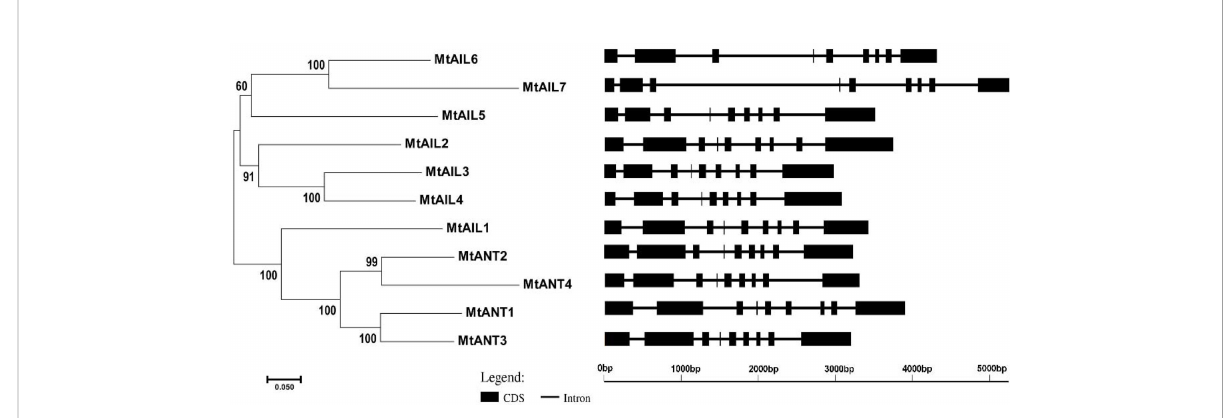
FIGURE 2 The phylogenetic relationship and exon/intron structural analyses of all AILs in M. truncatula . Introns are represented by black lines and exons are represented by black boxes. Phylogenetic tree was constructed using MEGA6.06 by the Neighbor-Joining